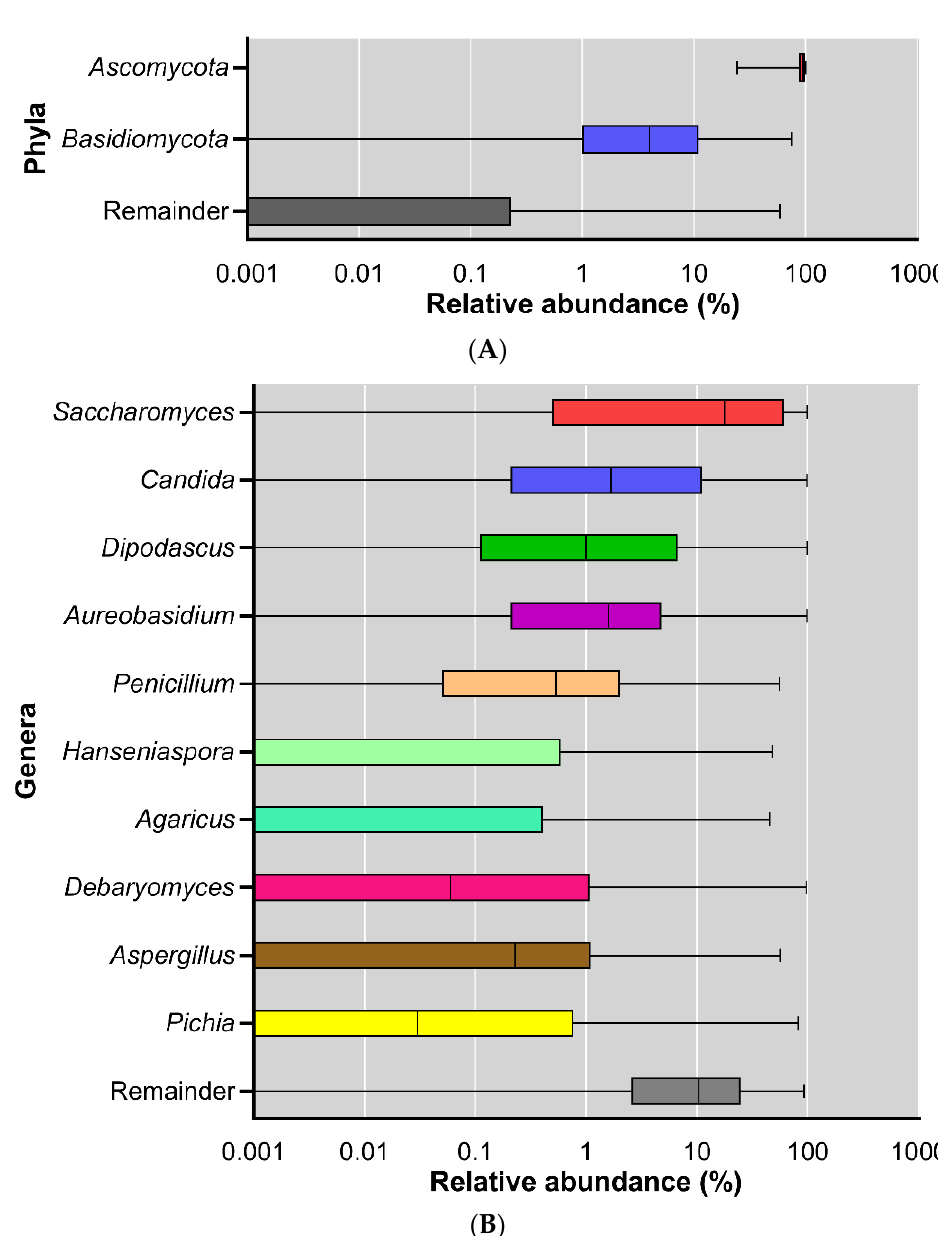
Figure 3. Relative abundance of fungi across all subjects; displayed at log scale; ( A ) phylum level; ( B ) genus level.